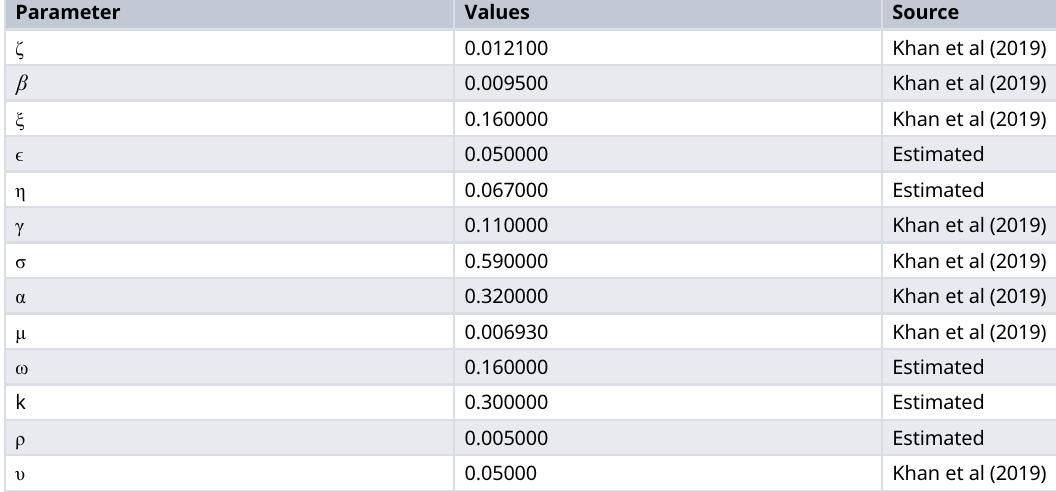
Table 3. Parameter values used for the numerical